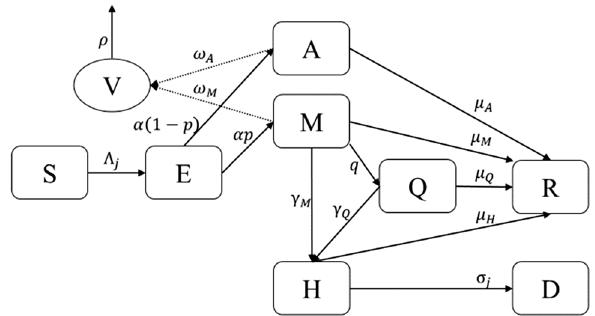
Figure 1. Schematic diagram of transitions of individuals between compartments in which transmission and transition rates are indicated over the arrows. See Table S3 for definition of model’s parameters. The force of infection (cid:31) j is given in Eq. (1), which depends on the environmental contact matrix (C V ) and social contact matrices (C) for school, work, household, and